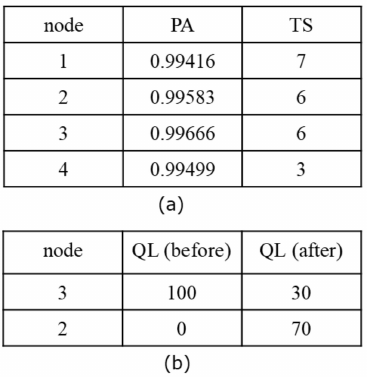
Figure 2. PA and TS values for each node in the example network of Figure 1 ( a ), and QL change after transmission on link <3,2> ( b